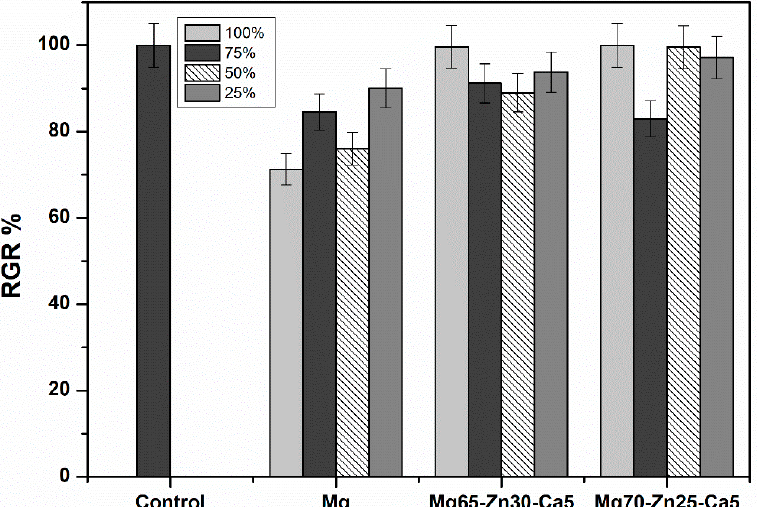
Figure 13. Cytotoxicity test results.